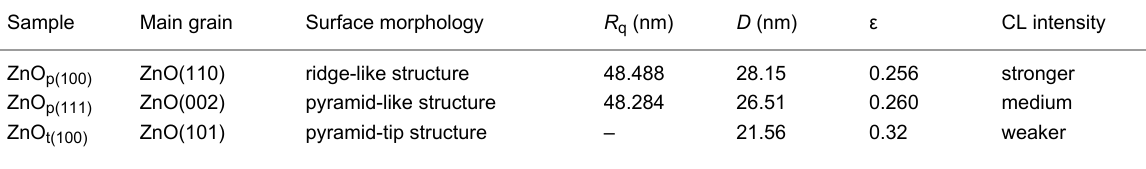
Table 1: Main grain, surface morphology, surface roughness ( R q ) from AFM, average grain size ( D ), strain ( ε ), and cathode luminescence (CL) inten- sity of the samples ZnO p(100) , ZnO p(111) , and ZnO t(100)